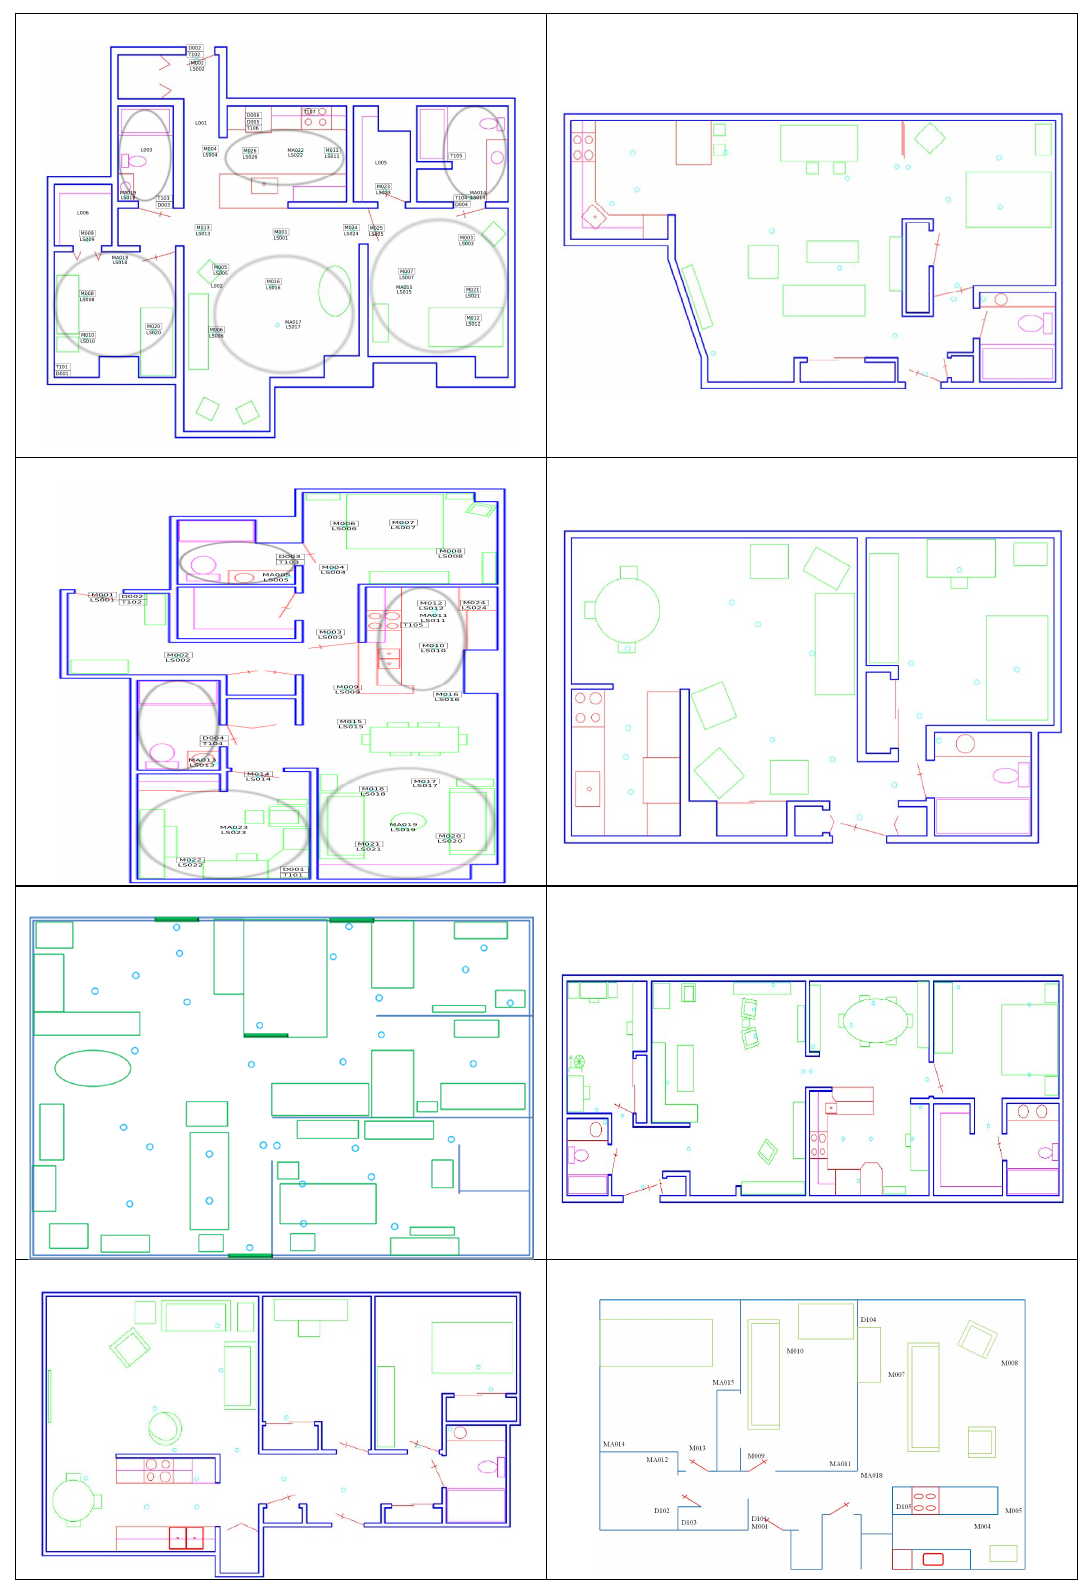
Figure 4. Smart home floorplans. Left column from top to bottom: Home 1, Home 2, Home 3, and Home 4. Right column from top to bottom: Home 5, Home 6, Home 7, and Home